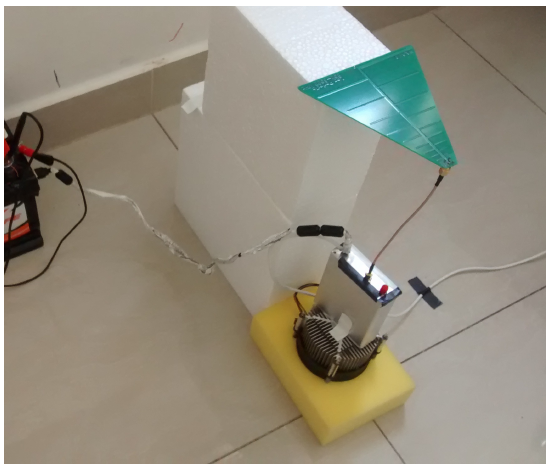
Figure 4. The Tx radio is connected to the transmitting antenna by an SMA RG316 coaxial cable. On the left is the connection to the power supply (battery is partially shown); on the right is the USB cable going to the computer (during the tests, its connector was placed inside the case to improve